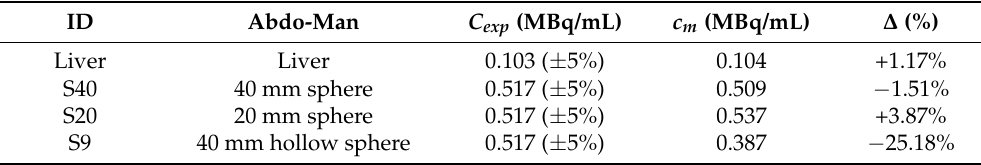
Table 4. Recovered activities for the liver and the three spherical lesions in the Abdo-Man phantom.